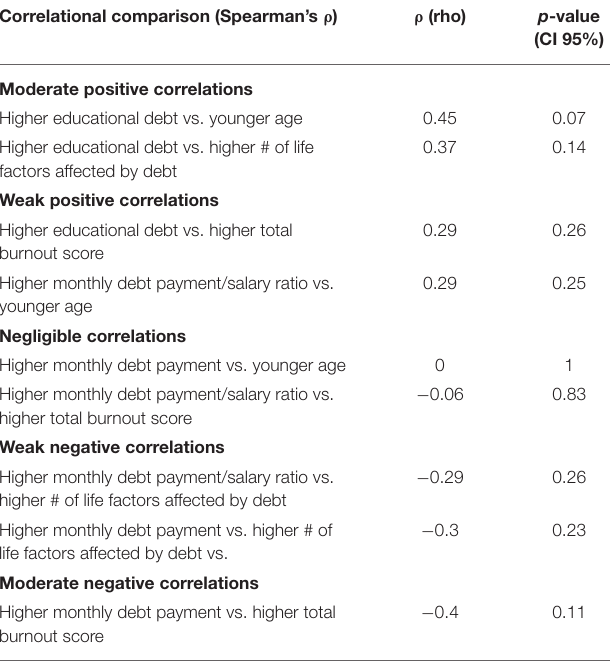
TABLE 4 | Correlational comparison between each of (educational debt, monthly debt payment/salary ratio, and monthly debt payment) with each of (number of life factors impacted by debt, age, and burnout